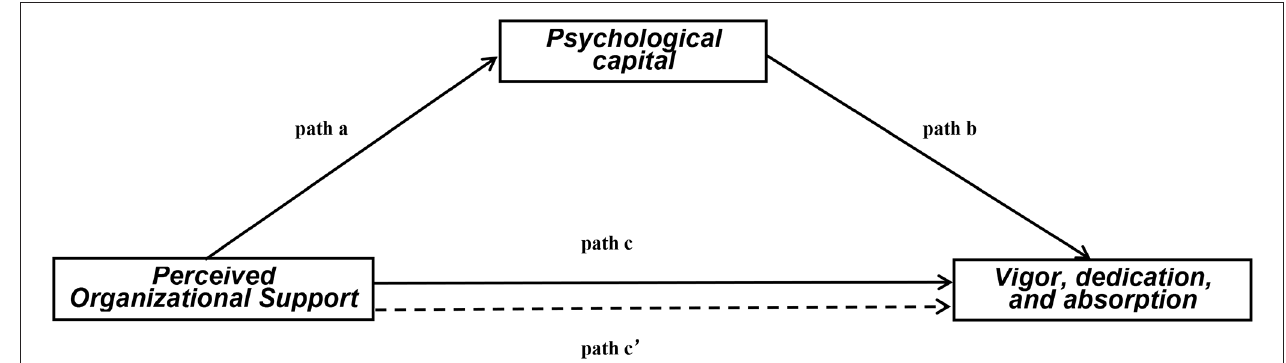
FIGURE 1 | Theoretical model of the mediating role of PsyCap on the association between POS and work engagement. c: association of POS with vigor, dedication and absorption; a: association of POS with PsyCap; b: association between PsyCap and vigor, dedication, and absorption after controlling for the covariates; c ′ : association of POS with vigor, dedication, and absorption after adding PsyCap as a mediator; c = c ′ + ab. POS, perceived organizational support; PsyCap, psychological